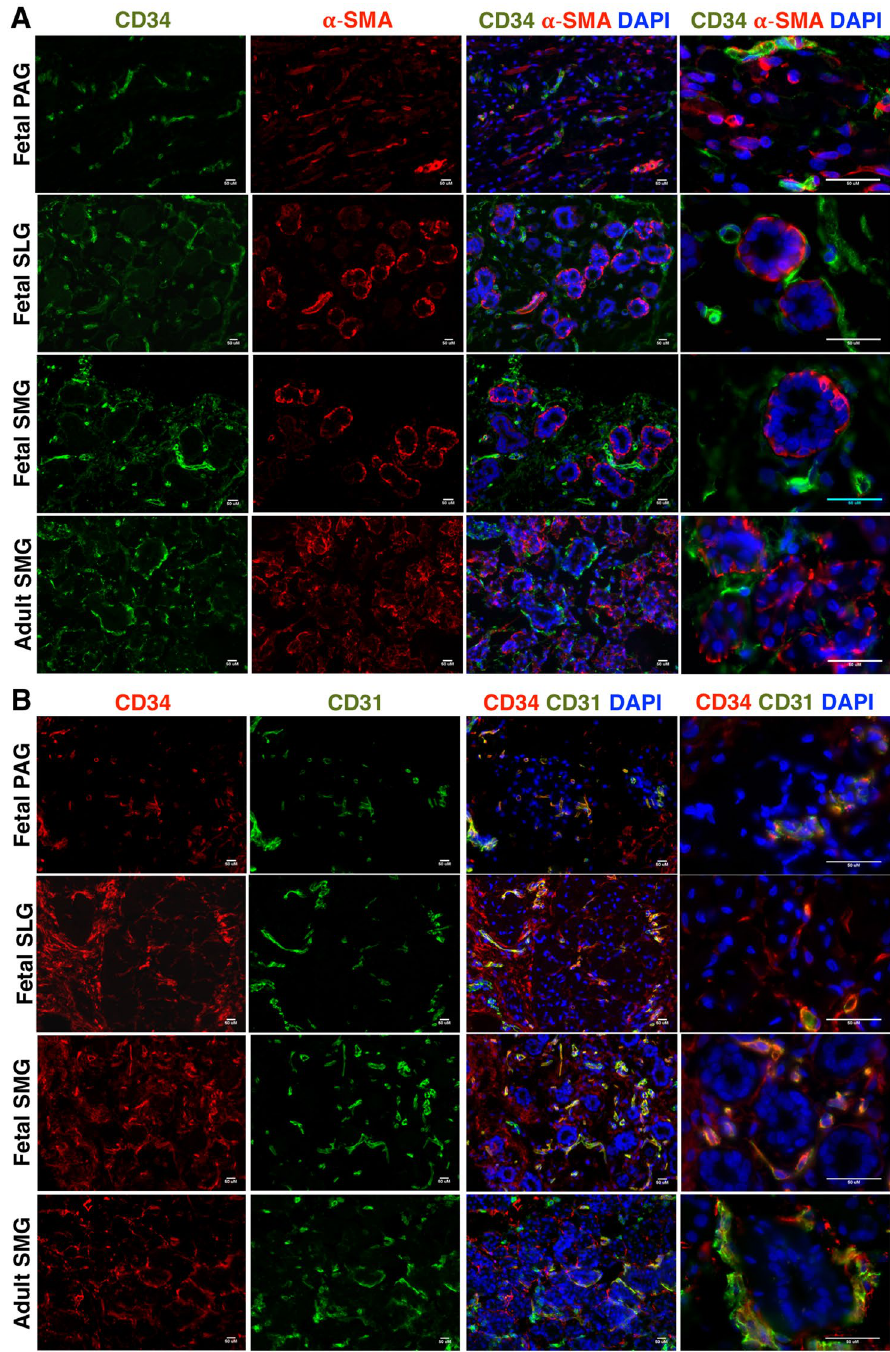
Figure 3. In situ localization of ( A ) CD34 (green) and α -SMA (red) ( B ) CD34 (red) and CD31 (green) in fetal SGs and adult SMGs. All scale bars represent 50 µ